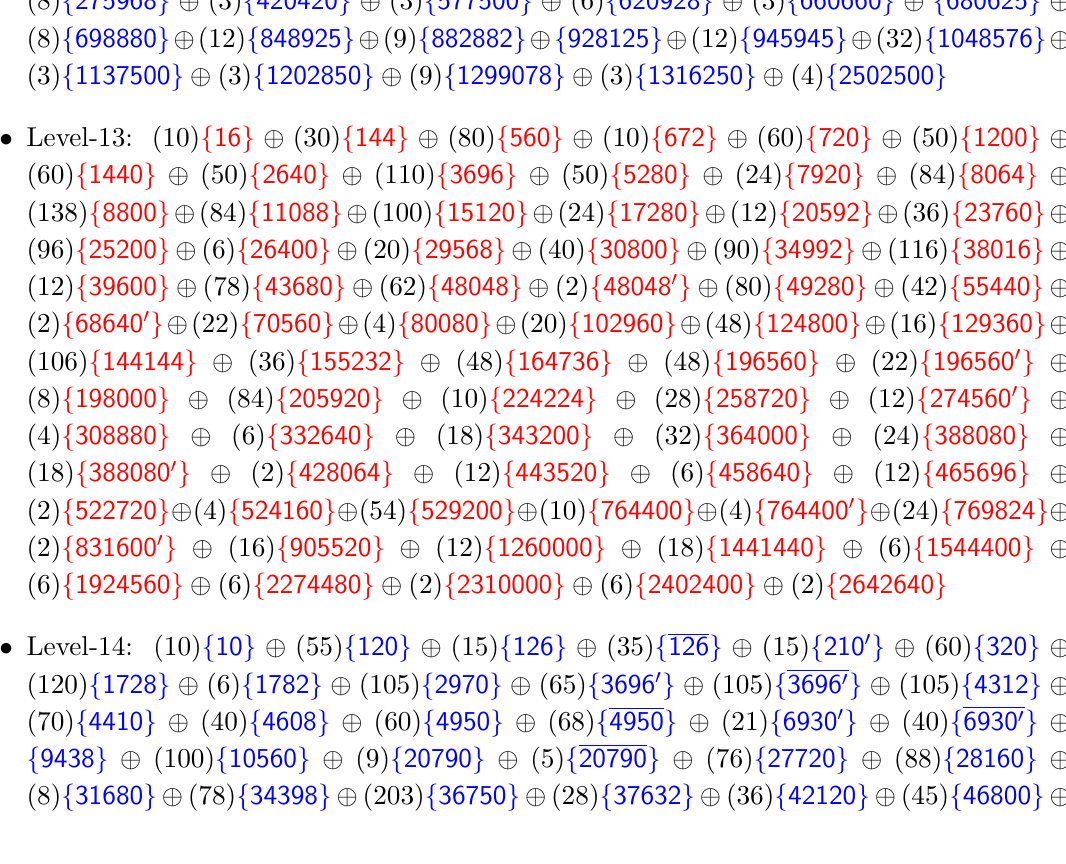
(cid:15) Level-11: (2) f 16 g (cid:8) (20) f 144 g (cid:8) (30) f 560 g (cid:8) (22) f 672 g (cid:8) (40) f 720 g (cid:8) (42) f 1200 g (cid:8) (24) f 1440 g (cid:8) (42) f 2640 g (cid:8) (82) f 3696 g (cid:8) (22) f 5280 g (cid:8) (20) f 7920 g (cid:8) (36) f 8064 g (cid:8) (86) f 8800 g (cid:8) (2) f 9504 g (cid:8) (60) f 11088 g (cid:8) (72) f 15120 g (cid:8) (20) f 17280 g (cid:8) (2) f 20592 g (cid:8) (12) f 23760 g (cid:8) (66) f 25200 g (cid:8) (16) f 29568 g (cid:8) (32) f 30800 g (cid:8) (48) f 34992 g (cid:8) (72) f 38016 g (cid:8) (4) f 39600 g (cid:8) (36) f 43680 g (cid:8) (30) f 48048 g (cid:8) (56) f 49280 g (cid:8) (20) f 55440 g (cid:8) (8) f 70560 g (cid:8) (12) f 80080 g (cid:8) (24) f 102960 g (cid:8) (36) f 124800 g (cid:8) (10) f 129360 g (cid:8) (64) f 144144 g (cid:8) (18) f 155232 g (cid:8) (12) f 164736 g (cid:8) (6) f 185328 g (cid:8) (24) f 196560 g (cid:8) (2) f 203280 g (cid:8) (32) f 205920 g (cid:8) (12) f 258720 g (cid:8) (2) f 332640 g (cid:8) (2) f 343200 g (cid:8) (24) f 364000 g (cid:8) (10) f 388080 g(cid:8) (4) f 443520 g(cid:8) (4) f 458640 g(cid:8) (12) f 465696 g(cid:8) (6) f 498960 g(cid:8) (16) f 529200 g(cid:8) (6) f 764400 g(cid:8) (18) f 769824 g(cid:8) (6) f 784784 g(cid:8) (2) f 990000 g(cid:8) (6) f 1260000 g(cid:8) (2) f 1544400 g (cid:15) Level-12: f 1 g (cid:8) (10) f 45 g (cid:8) (15) f 54 g (cid:8) (25) f 210 g (cid:8) (15) f 660 g (cid:8) (45) f 770 g (cid:8) (60) f 945 g (cid:8) (35) f 1050 g (cid:8) (66) f 1050 g (cid:8) (50) f 1386 g (cid:8) (6) f 2772 g (cid:8) (16) f 2772 g (cid:8) (46) f 4125 g (cid:8) f 4290 g (cid:8) (93) f 5940 g (cid:8) (33) f 6930 g (cid:8) (50) f 6930 g (cid:8) (13) f 7644 g (cid:8) (105) f 8085 g (cid:8) (30) f 8910 g (cid:8) (15) f 12870 g (cid:8) (52) f 14784 g (cid:8) (36) f 16380 g (cid:8) (46) f 17325 g (cid:8) (30) f 17325 g(cid:8) (104) f 17920 g(cid:8) (72) f 23040 g(cid:8) (80) f 23040 g(cid:8) (32) f 50688 g(cid:8) (24) f 50688 g(cid:8) f 52920 g (cid:8) (7) f 64350 g (cid:8) (33) f 70070 g (cid:8) (104) f 72765 g (cid:8) (57) f 73710 g (cid:8) (24) f 81081 g (cid:8) f 84942 g (cid:8) (9) f 90090 0 g (cid:8) (3) f 105105 g (cid:8) (44) f 112320 g (cid:8) (5) f 123750 g (cid:8) (3) f 124740 g (cid:8) (5) f 126126 g(cid:8)f 126126 g(cid:8) (38) f 128700 g(cid:8) (30) f 128700 g(cid:8) (87) f 143000 g(cid:8) (27) f 174636 g(cid:8) (18) f 189189 g (cid:8) (45) f 199017 g (cid:8) (18) f 199017 g (cid:8) (24) f 207360 g (cid:8) (16) f 210210 g (cid:8) (8) f 219648 g (cid:8) (21) f 242550 g (cid:8) (16) f 242550 g (cid:8) (22) f 274560 g (cid:8) (24) f 275968 g (cid:8) (8) f 275968 g (cid:8) (3) f 420420 g (cid:8) (3) f 577500 g (cid:8) (6) f 620928 g (cid:8) (3) f 660660 g (cid:8) f 680625 g (cid:8) (8) f 698880 g(cid:8) (12) f 848925 g(cid:8) (9) f 882882 g(cid:8)f 928125 g(cid:8) (12) f 945945 g(cid:8) (32) f 1048576 g(cid:8)